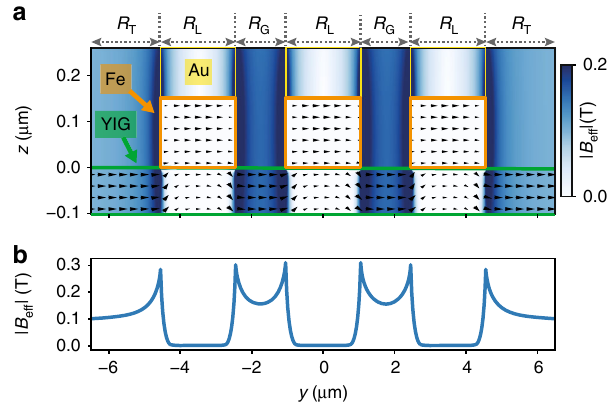
Fig. 3 Micromagnetic simulation and line plot of effective magnetic fi eld generated by mCPW. a Cross-sectional view of an mCPW on YIG where the different layers of Au, Fe, and YIG are indicated in yellow, orange, and green color, respectively. Arrows are extracted from micromagnetic simulations, and display the local magnetization vectors in the y , z plane for a fi eld of 0.09 T applied in positive y -direction ( θ = 90°). The color coding of the background (legend on the right) indicates the magnetic fi eld B eff taken from simulations, which varies locally and enters the equation of motion. b Line plot of the absolute B eff inside YIG along the path of BLS spectroscopy as indicated in Fig. 1a. Source data are provided as a Source Data fi